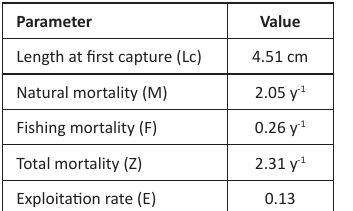
Table 3. Mortality related parameters for the population of Acanthocobitis mooreh